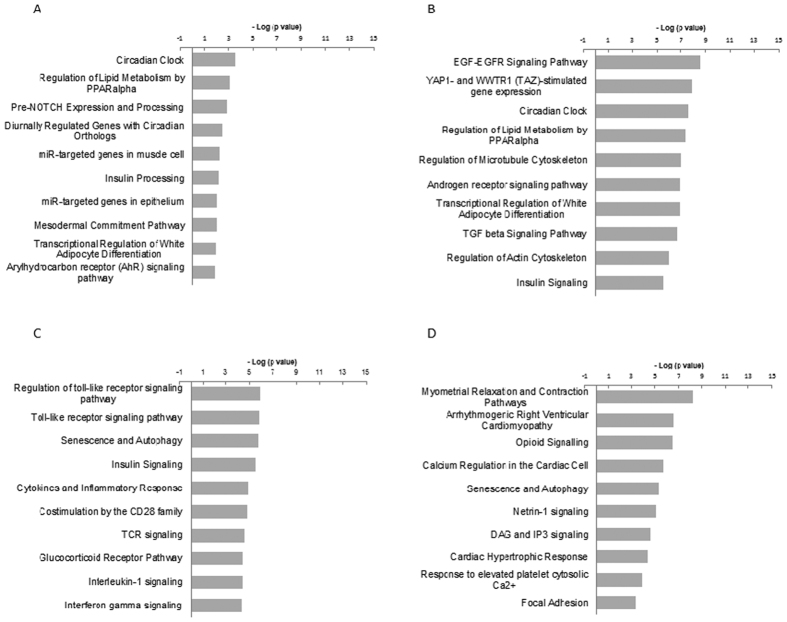
Top 10 pathways enriched for pathway analysis through WikiPathways in downregulated genes.The results from the pathway analysis through WikiPathways are depicted within the category of downregulated genes. (A) LUV, at 4 h (B) HUV, at 4 h (C) LUV, at 12 h (D) HUV, at 12 h. The Y-axis shows the minus logarithmic value of each p-value indicating the validity of each pathway in the same manner as in Fig. 2. The accession number of each pathway for WikiPathways was saved; refer to the raw data in Supplementary Tables S9–12.